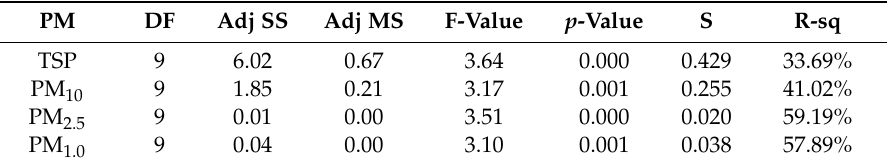
Table 5. General linear analysis of area and atmospheric suspended particulate matter concentration.